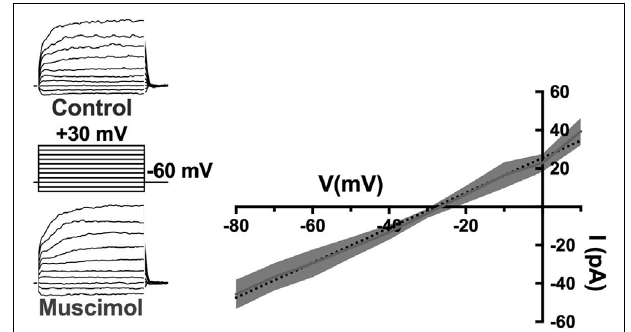
FIGURE 8 | The GABA-agonist muscimol activates depolarizing currents in horizontal cells. Recordings of tdTomato-labeled mouse horizontal cells in slices produced currents in response to the voltage steps that were larger in the presence of 100 µ M muscimol. Subtracting the control currents from those in muscimol produced a linear current-voltage relation reversing at − 28 mV (I–V relation averaged from five horizontal cells; dotted line is a linear fit of mean subtracted currents, gray region indicates standard deviations). Gramicidin-perforated patch-clamp recording keeps intracellular [Cl − ] intact, suggesting horizontal cells have a very elevated [Cl − ] equilibrium potential as other studies have shown. Figure modified from Grove et al.